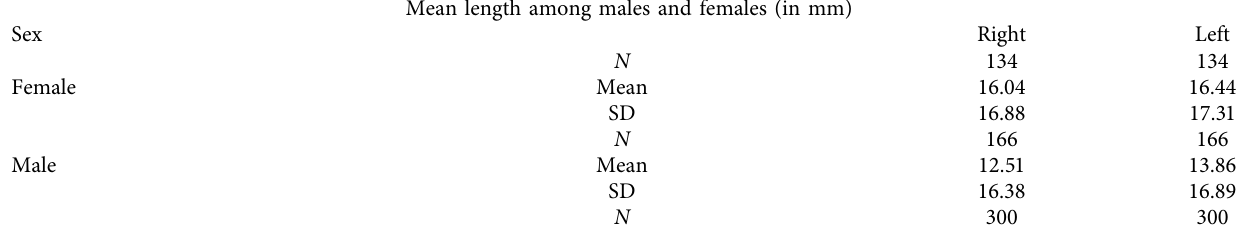
Table 3: Association of styloid process elongation, symptoms, and sides of the symptoms between males and females. Mean length among males and females (in